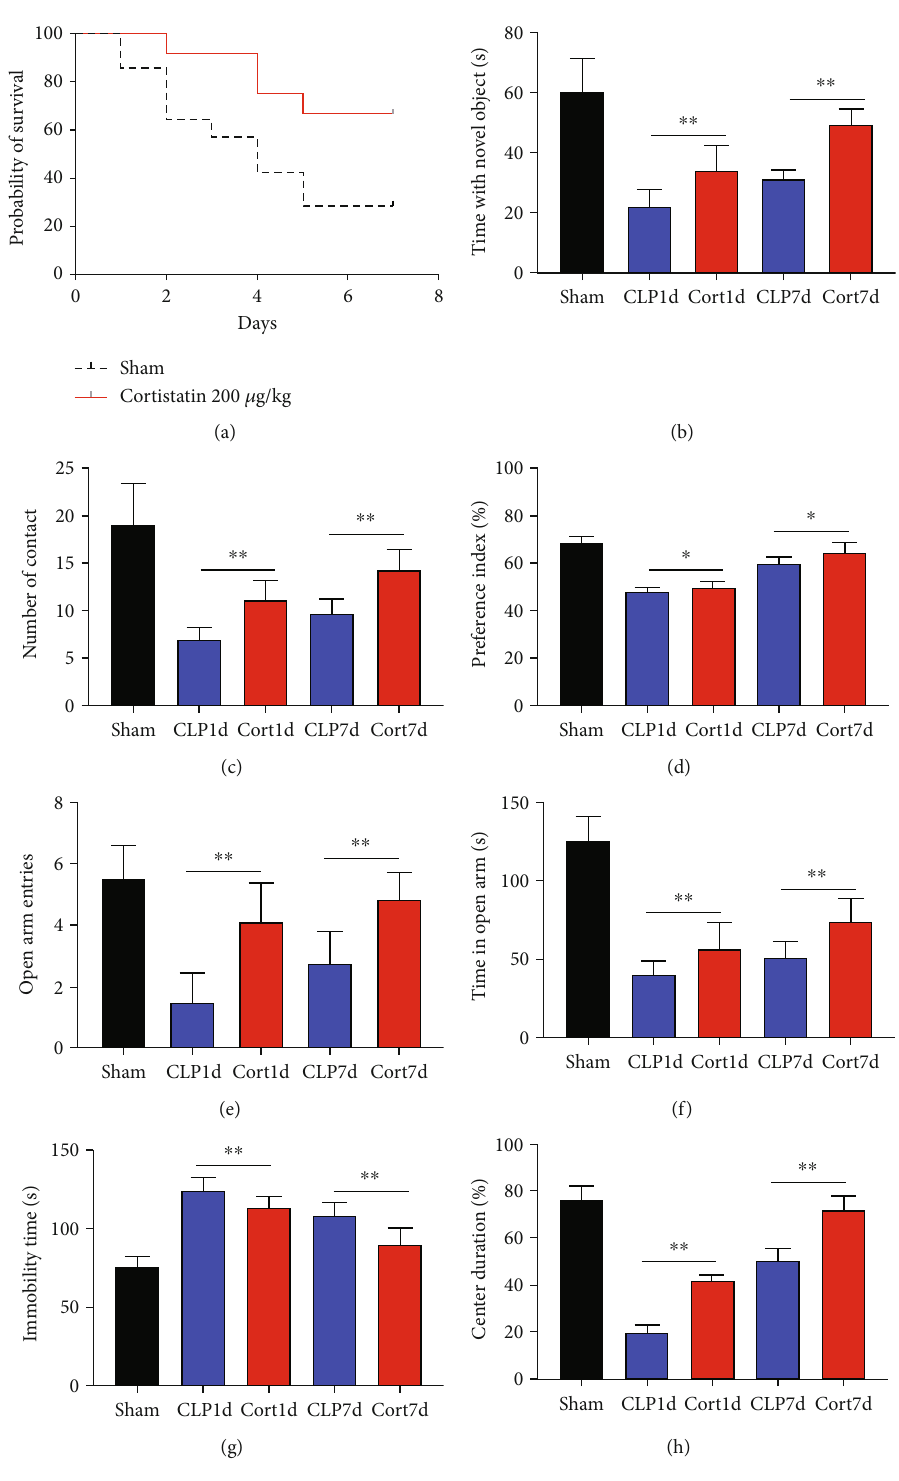
Figure 2: Cortistatin improved overall survival and cognitive and emotional impairement of CLP-induced sepsis in mice. (a) Survival curve. Four of 14 mice of the CLP group survived on day 7. Eight of 12 mice of the cortistatin group survived. (b) – (d) Time spent with a novel object, contacts with the novel object, and preference index in the novel object recognition test, respectively. (e),and (f) Entries of the open arms and time consumed in the open arms in the elevated plus maze test, respectively. (g) Total immobility time during 5min in the tail suspension test. (h) Percentage of center duration in the 5 min in the open fi eld test. Data were shown as mean ± standard deviation (n =8 per group). ∗ P < 0.05 and ∗∗ P <